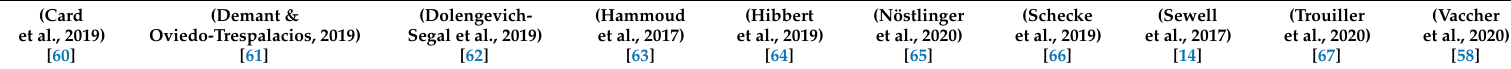
Table 4. Psychological instruments